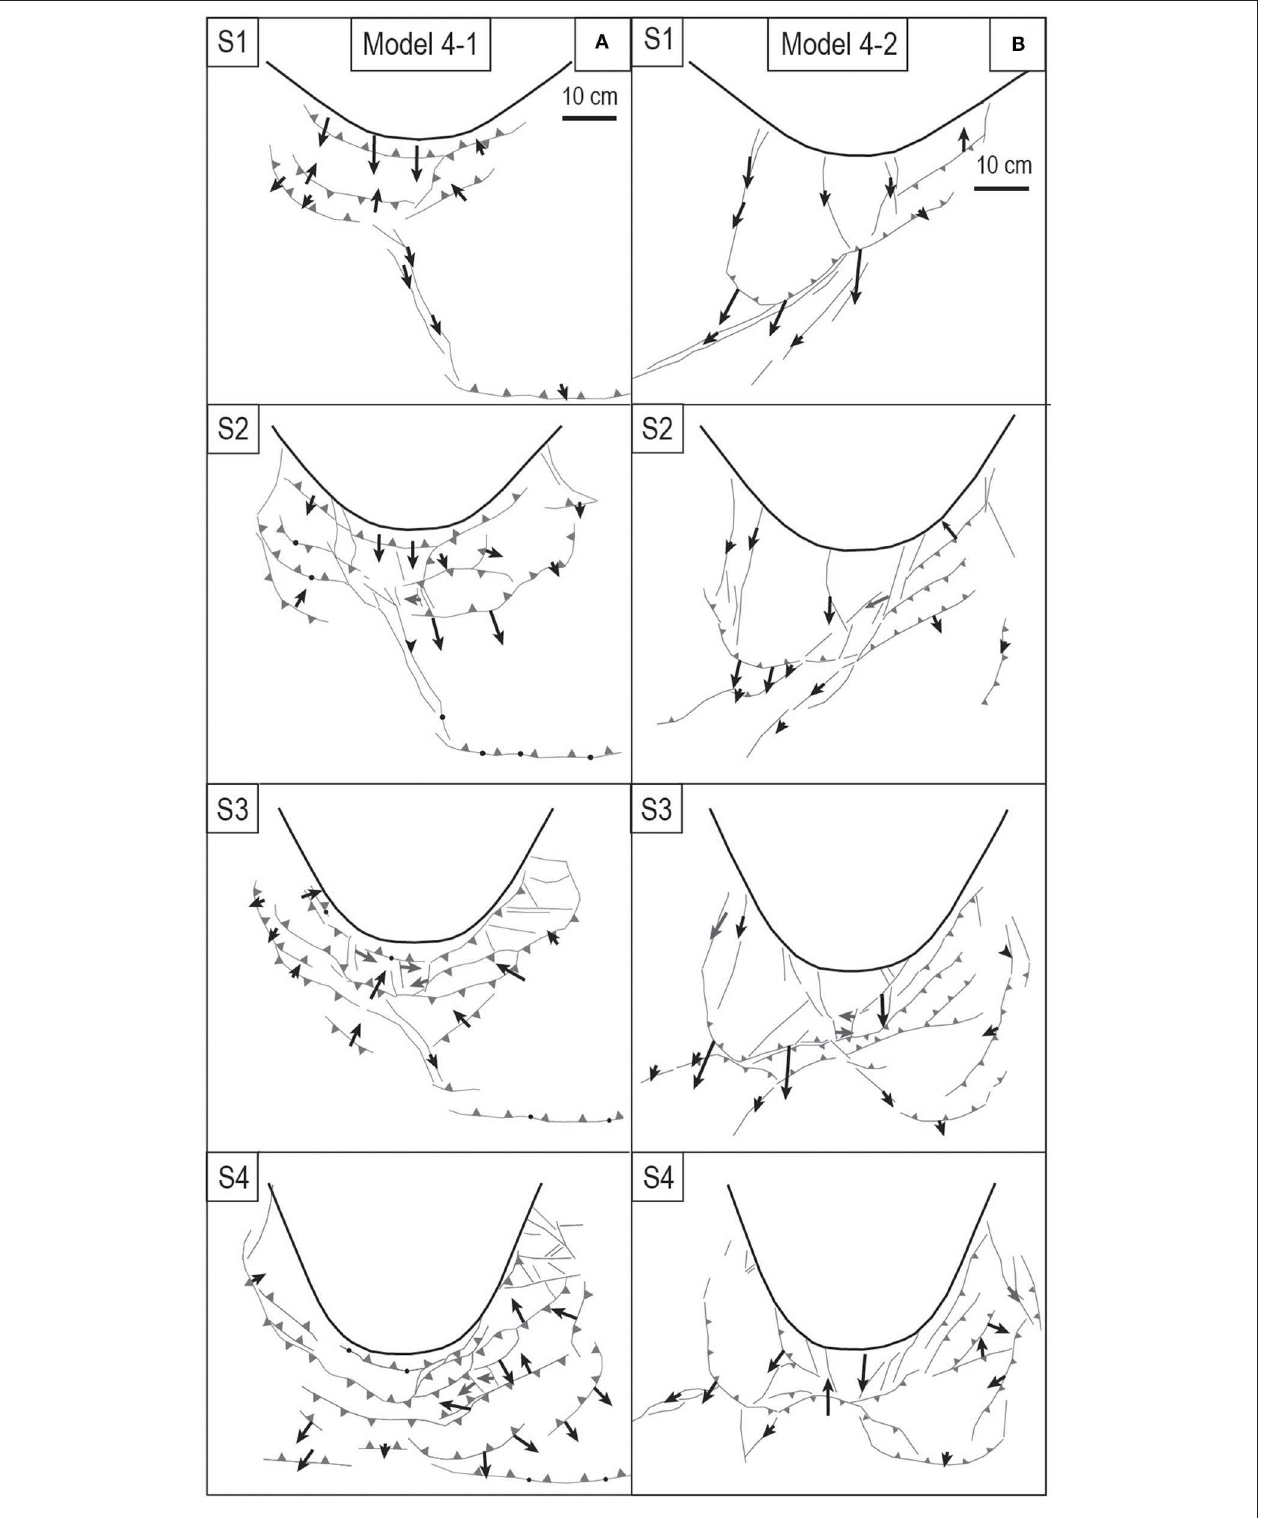
FIGURE 10 | Displacement vectors associated with the main structures at the different stages of Models 4-1 (A) and 4-2 (B) . The length of the arrows represents the magnitude of the displacement with the same scale of the line drawings. Black arrows: movement on thrust. Gray arrows: movement on normal fault. Other symbols: Idem Figures 6 , 7